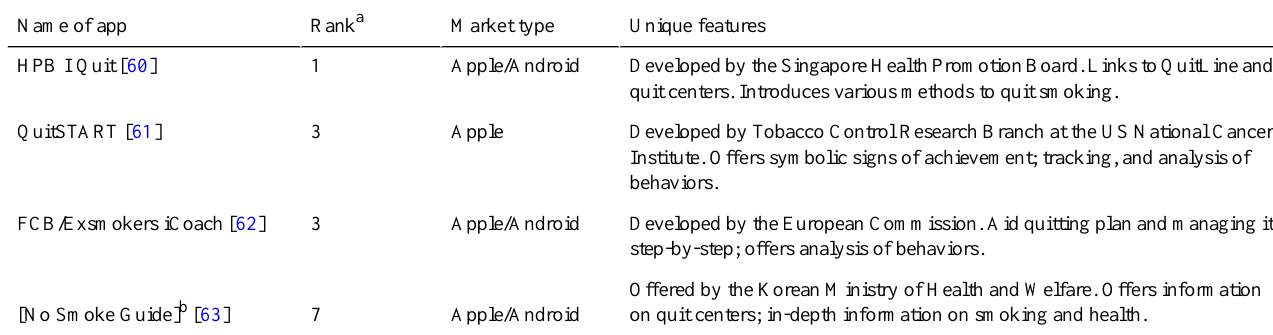
Table 5. Top-ranked smoking cessation apps developed in the public